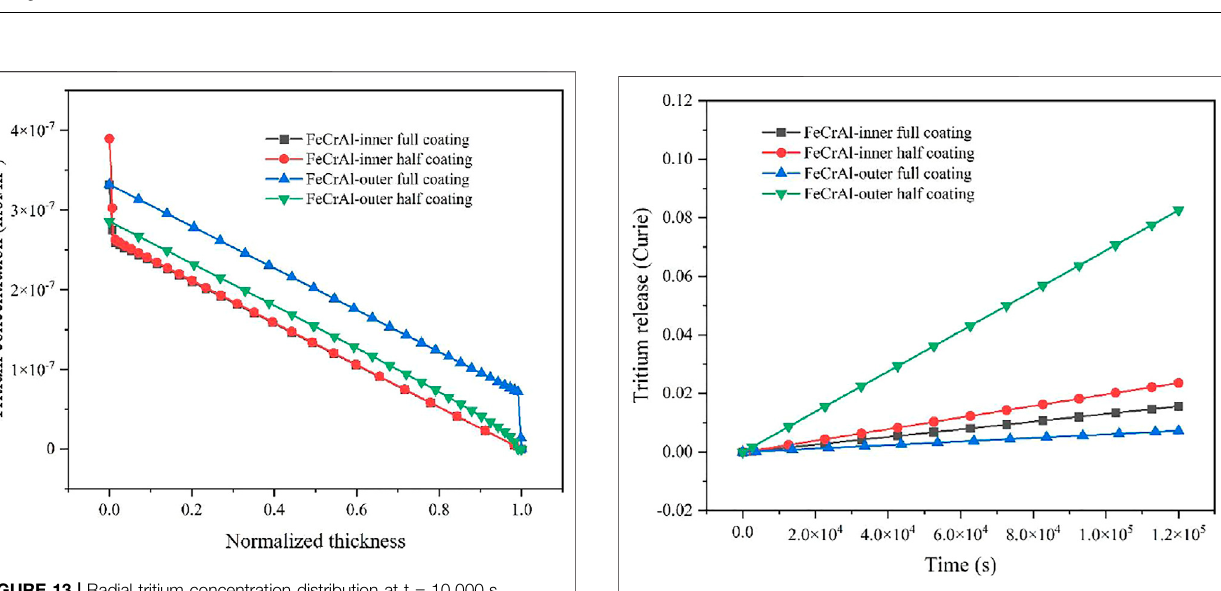
Frontiers in Energy Research |